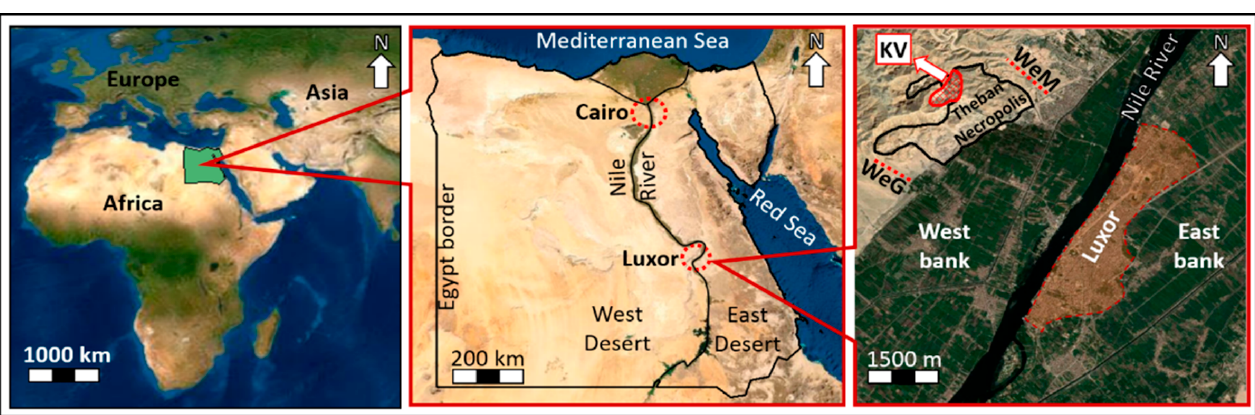
Figure 1. Geographical location of the Thebes Necropolis within Luxor, Egypt, with red hashed area indicating the Valley of the Kings (KV), and WeG and WeM stand for Wadi Gabbanat el-Gouroud and Wade el-Machtiar, respectively.